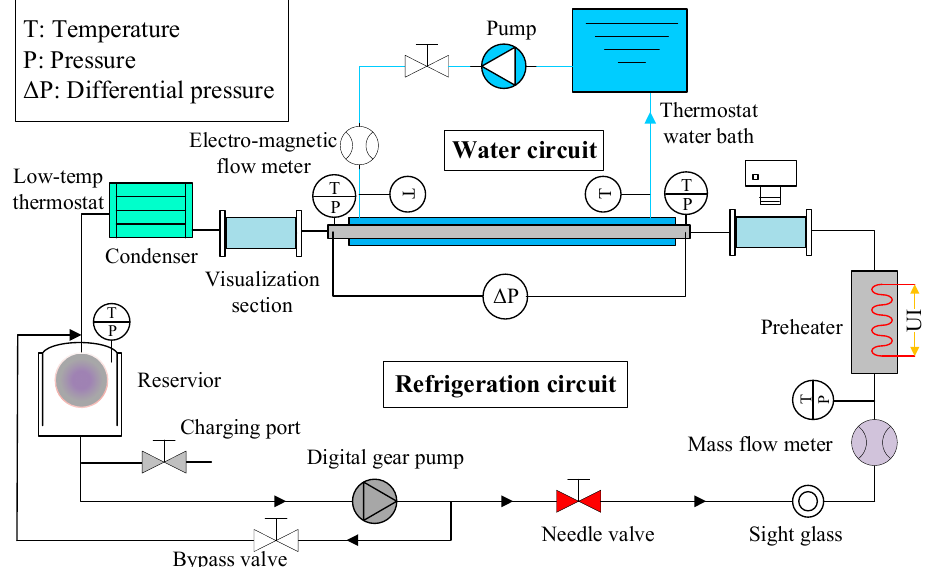
Figure 1. Schematic diagram of the experimental setup.